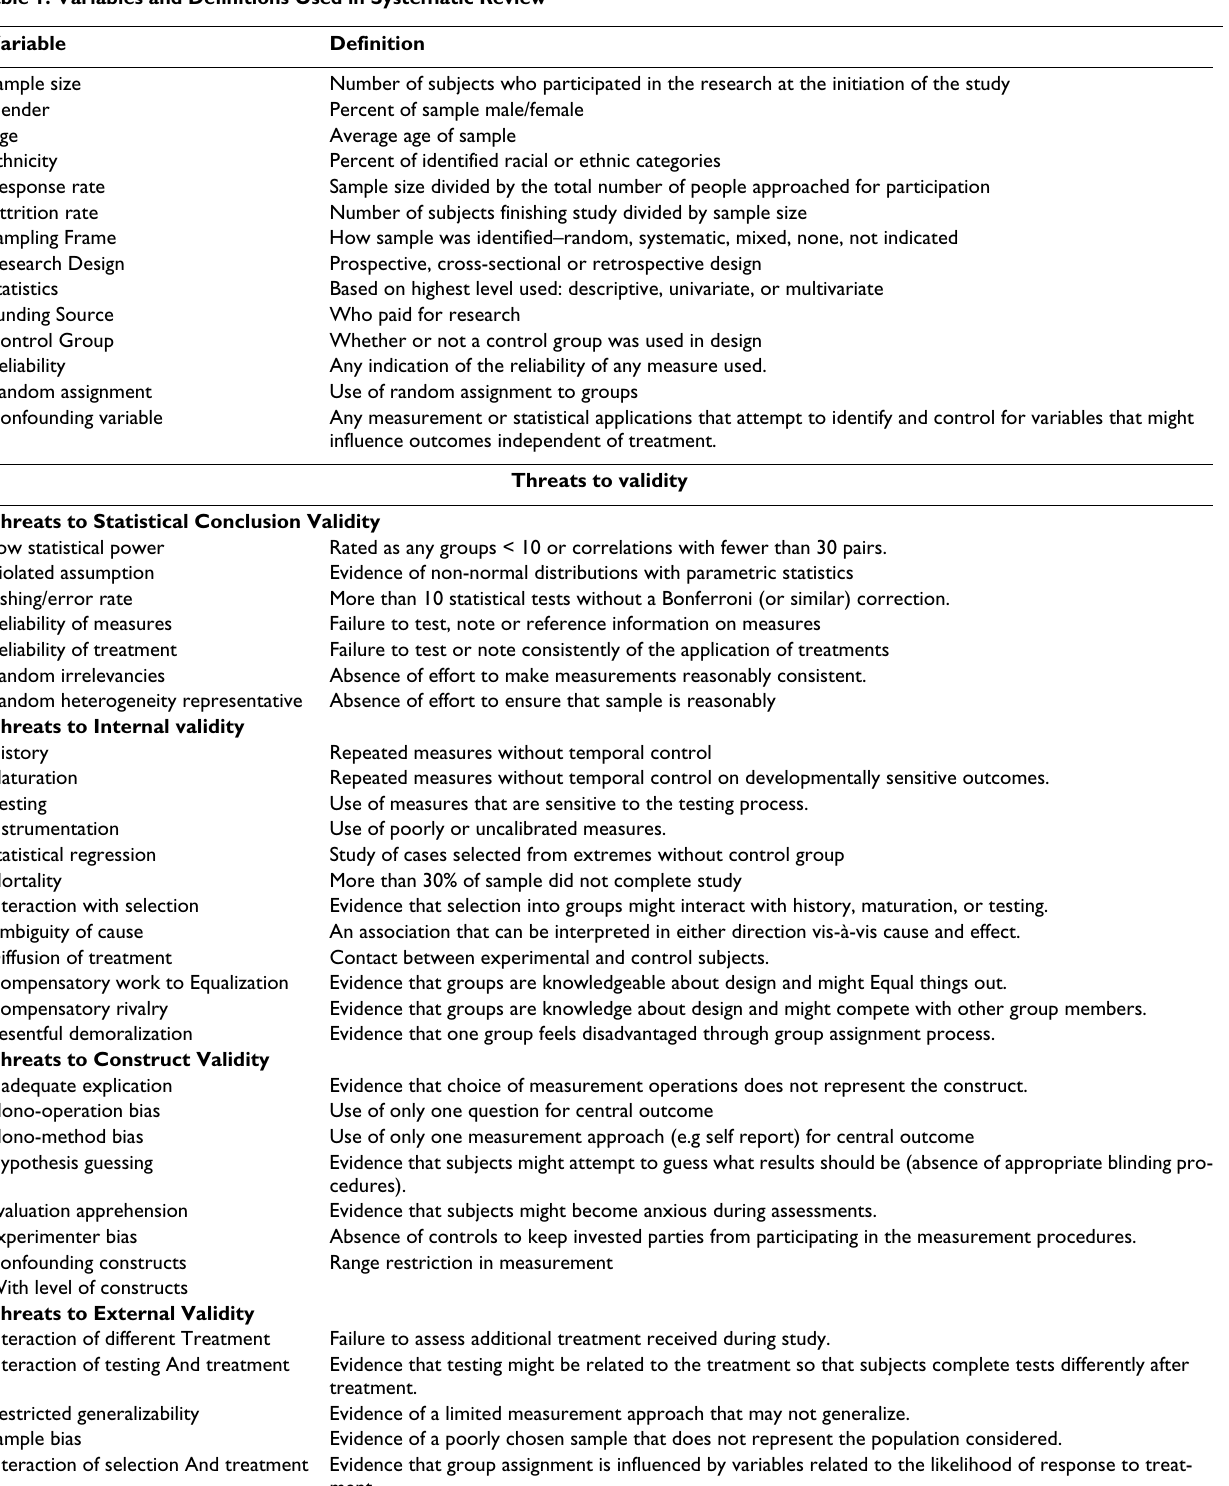
Table 1: Variables and Definitions Used in Systematic